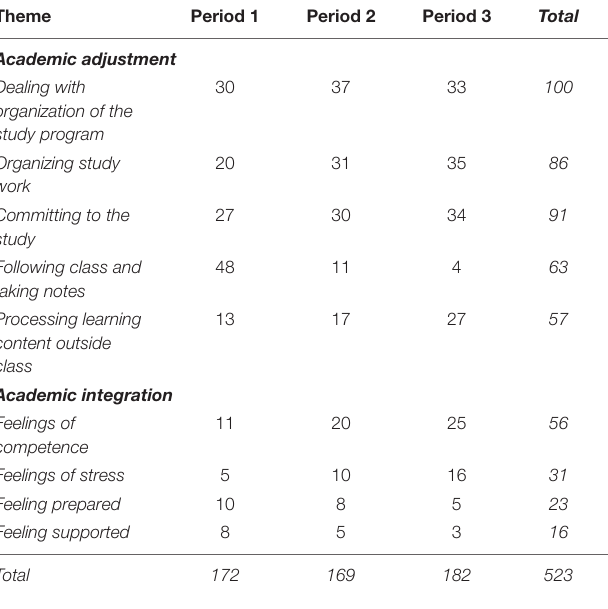
TABLE 2 | References per theme per time